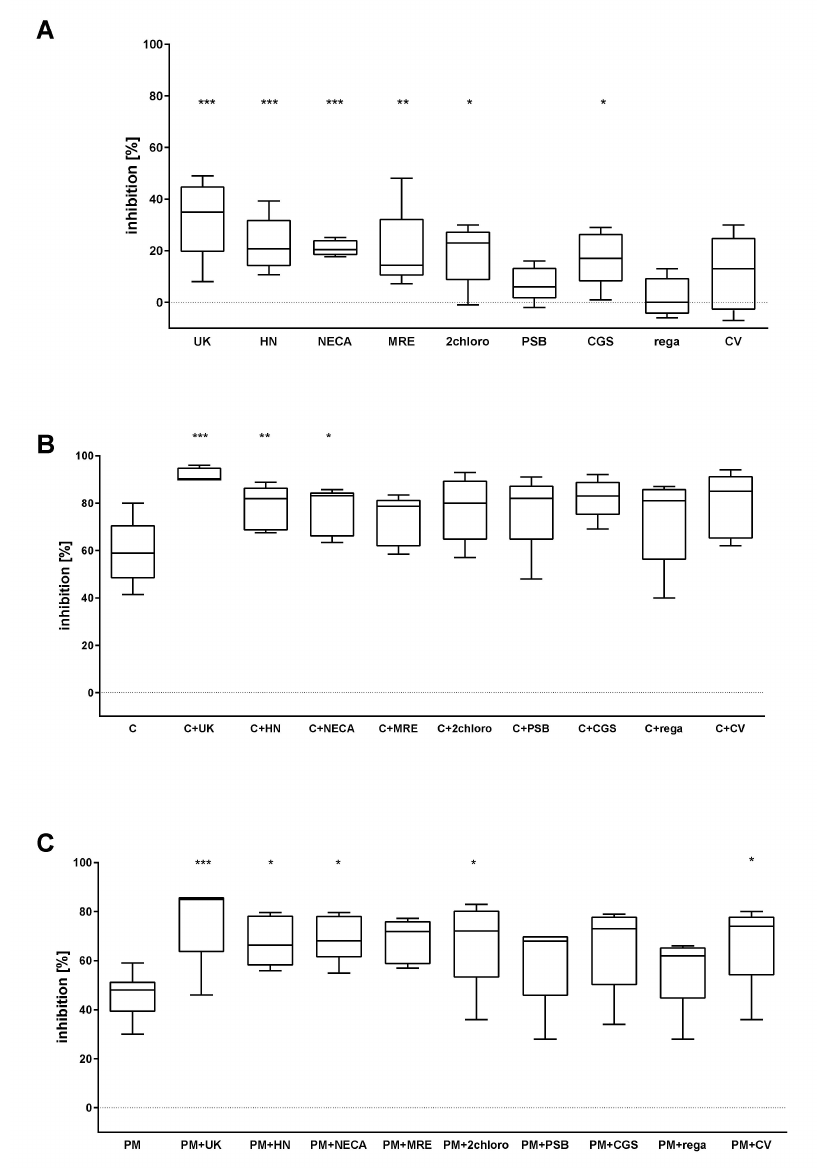
Figure 2. AR agonists intensify the inhibitory e ff ect of P2Y 12 antagonists on platelet reactivity, as measured by P-selectin expression ( n = 5). ( A ) E ff ect of AR agonist on platelets, ( B ) e ff ect on platelets antagonised with the P2Y 12 inhibitor cangrelor, ( C ) e ff ect on platelets antagonised with the P2Y 12 inhibitor prasugrel metabolite (PM). Data are presented as median, interquartile range (box), and minimum and maximum values (whiskers). Platelet reactivity was measured after activation with 20 µ M ADP, in whole blood. Samples were preincubated at 37 ◦ C for 3 min with AR agonist and cangrelor, or 15 min with PM, all in their previously determined IC 50 . Statistical significance was estimated by one-way ANOVA for repeated measurements with the post hoc Bonferroni’s multiple comparisons test or Friedman’s test with Dunn’s correction for multiple comparisons. Groups containing AR agonists are compared to control samples: untreated samples for AR agonists alone ( A ), P2Y 12 inhibitor-treated samples for combined systems ( B , C ). * p < 0.05, ** p < 0.01, *** p <